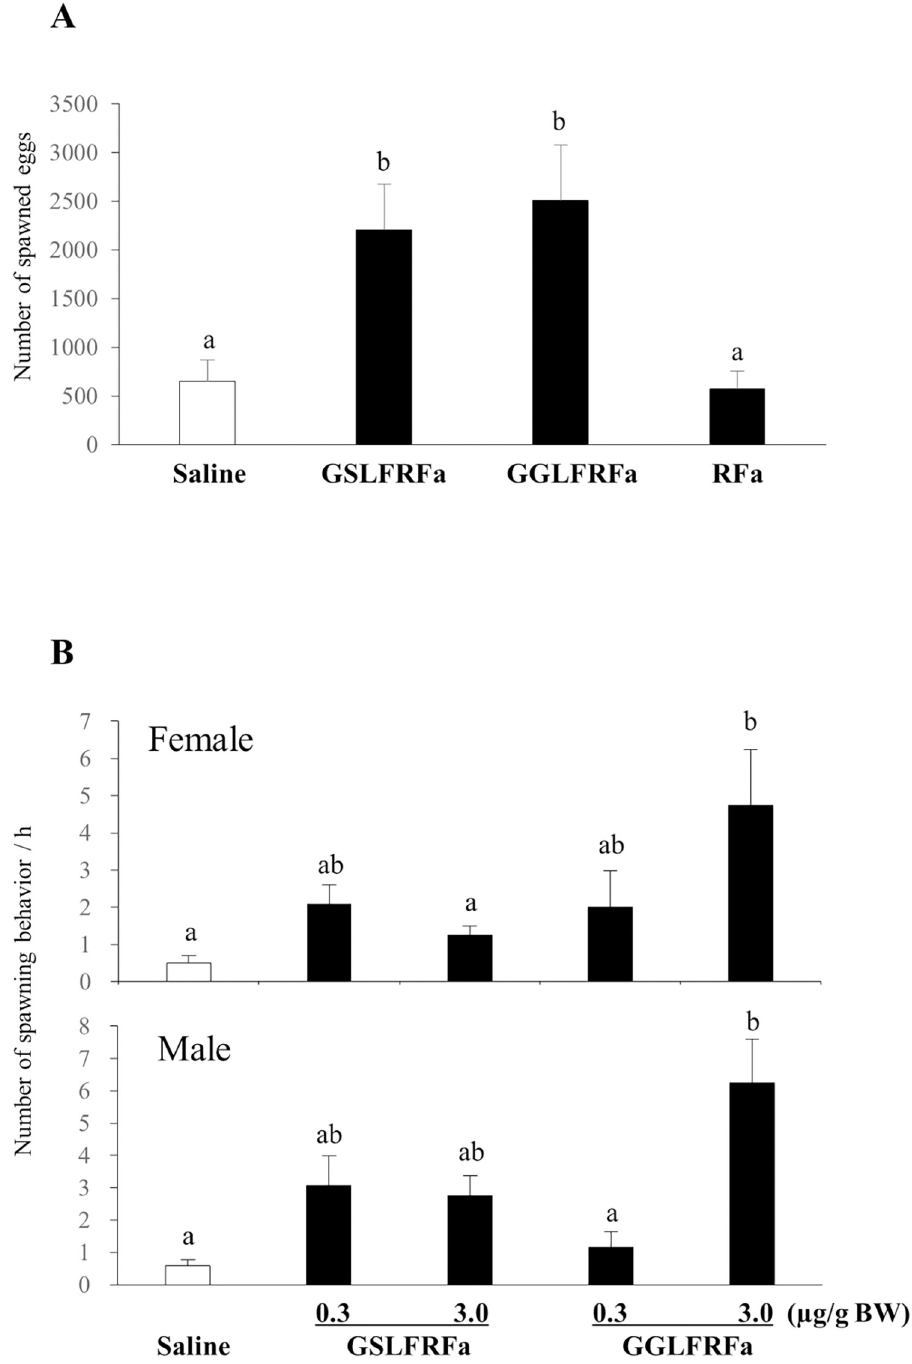
Fig 10. Effect of Hdh-LFRFa peptides on spawning in mature abalone. (A) Female abalone were injected with GSLFRFa, GGLFRFa, RFa (2.5 μ g/g BW per peptide), or the same volume of mollusk saline (n = 7 per group). The number of spawned eggs was counted at 2 h post-injection. (B) Female and male abalone were injected with GSLFRFa, GGLFRFa (0.3 or 3.0 μ g/g BW per peptide), or the same volume of mollusk saline (n = 12 per group). Spawning behavior was observed for 1 h after injection. Different letters indicate statistically significant differences (p < 0.05).